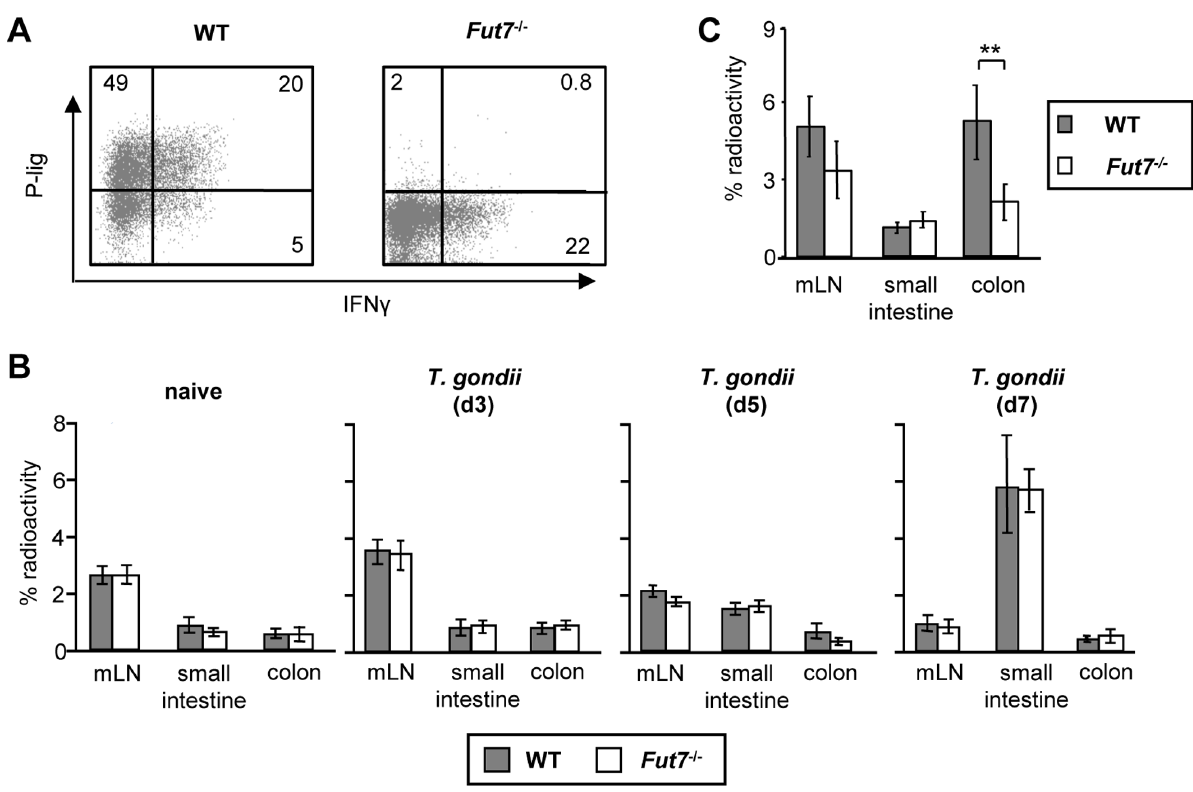
Figure 2. P-lig expression can support recruitment of Th1 cells into the inflamed colon but not into the inflamed small intestine. A) Naive T cells from wiltype (WT) and Fut7 2 / 2 mice were differentiated in vitro under Th1 polarizing conditions in the absence of RA. P-lig and PMA/ ionomycin-induced IFN c expression of Th1 cells generated from Fut7 2 / 2 and WT mice is shown. B) 51 Cr-labeled Th1 cells generated from WT or Fut7 2 / 2 mice were transferred into naive mice or mice infected orally with 100 cysts of T. gondii three, five or seven days before. Radioactivity (mean 6 SD ) per organ was determined three hours after transfer of radioactive T cells and is given as the percentage of total recovered radioactivity (n=5 animals/group). The experiment was repeated on d7 with 5 animals/group with similar results. C) 51 Cr-labeled Th1 cells from WT or Fut7 2 / 2 mice were injected into SCID mice with established colitis induced by transfer of CD4 + CD45Rb high cells. The percentage (mean and SD) of recovered radioactivity per organ of one representative experiment out of 3 independent experiments with 4–6 mice/ group is shown. **p , 0.01; Mann Whitney U test.